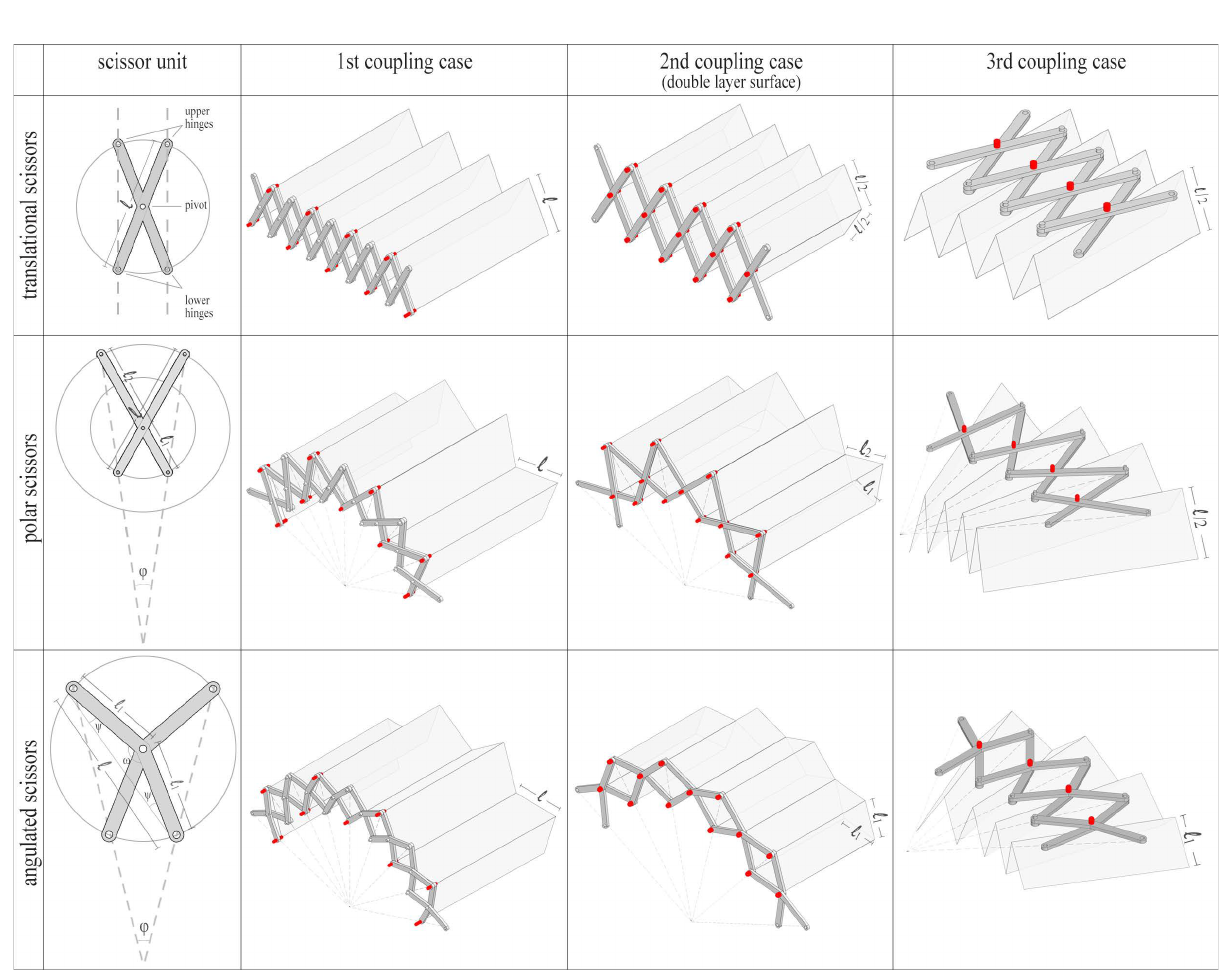
Figure 2: Scissor units and three general cases of coupling translational, polar and angulated linkages with accordion pleated